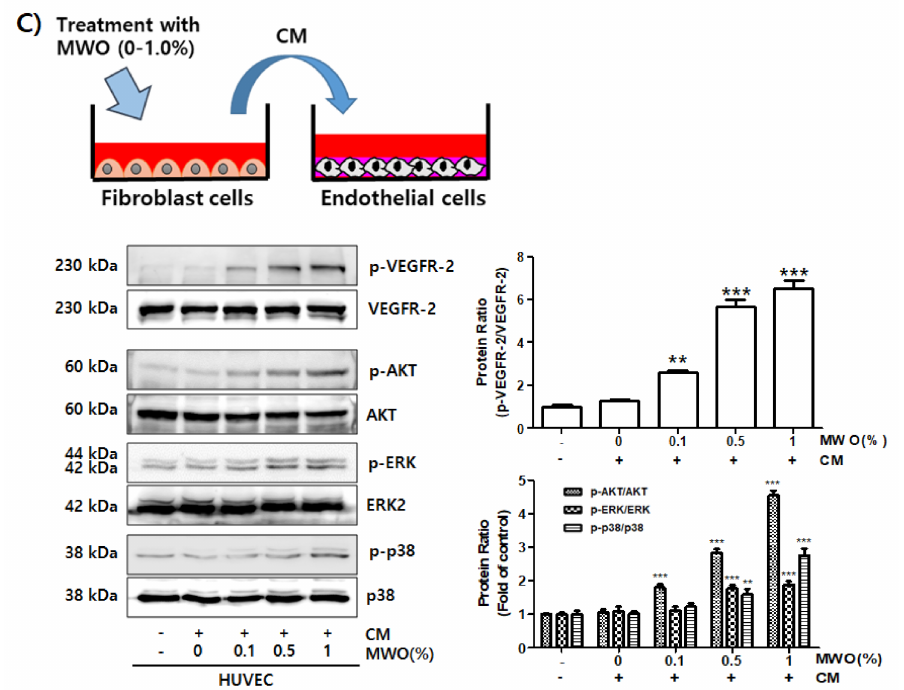
Figure 4. Effect of conditioned media (CM) from MWO-stimulated fibroblasts on tube formation and migration through VEGFR-2 activation of endothelial cells. ( A ) Endothelial cells were cultured on Matrigel-coated plates with the CM harvested from fibroblast cells treated with or without MWO. After 12 h of incubation, capillary-like tube formation was photographed with a Nikon light microscope. Quantitative summary of tube formation was performed by manual quantification of closed tubes. The values are shown as means ± SD. * p < 0.05 and *** p < 0.001 compared to the control. ( B ) The culture well was fully filled with endothelial cells. Wound gaps were then created by scratching with a scraper. The cells were treated with the CM harvested from fibroblast cells treated with or without MWO for 24 h. The migration of endothelial cells was observed and photographed with a Nikon light microscope. The quantitative evaluation of wound closure in the wound scratch assay was measured by the distance between the two front lines with the majority of migrated endothelial cells. The values are shown as means ± SD. ** p < 0.01 and *** p < 0.001 compared to the control. ( C ) The endothelial cells were treated with the CM harvested from fibroblast cells treated with or without MWO for 24 h. The total protein extracts harvested from the cells were analyzed by Western blot analysis with antibodies against VEGFR-2, phospho-VEGFR-2, AKT, phospho-_AKT, ERK1/2, phospho-ERK1/2, p38 and phospho-p38. Phosphorylated VEGFR2, AKT, ERK and p38 were standardized relative to their respective total proteins. The values are shown as means ± SD. ** p < 0.01 and *** p < 0.001 compared to the